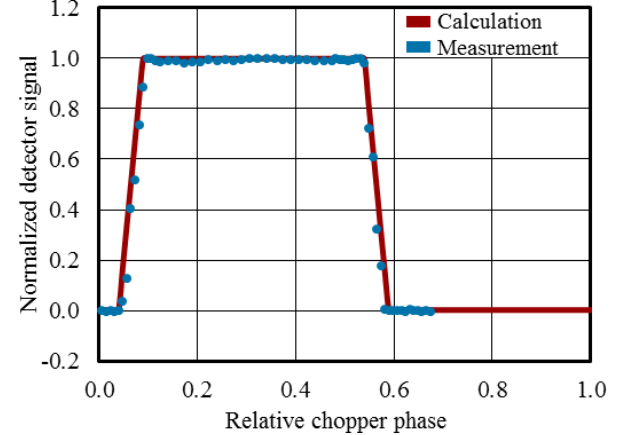
Figure 4. Normalized detector signal of the thermopile detector measured when turning the chopper wheel step by step at the cryo- genic electrical substitution radiometer facility (blue), which is in line with the trapezoid-shaped fit (red).